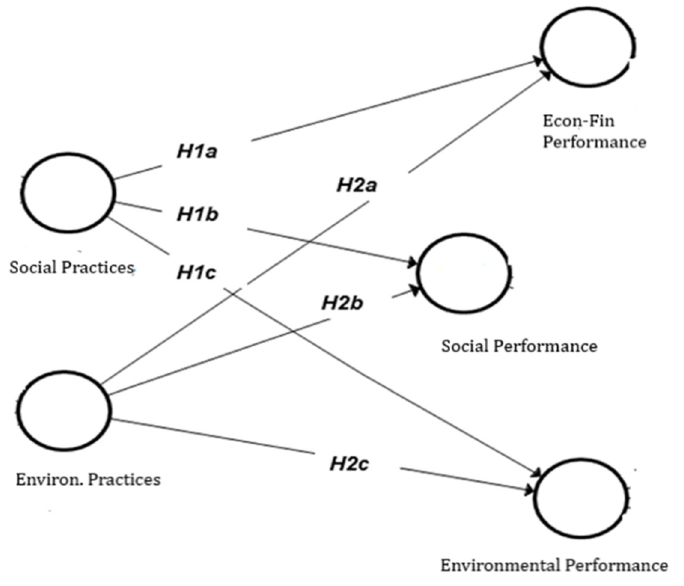
Figure 1. Conceptual model.